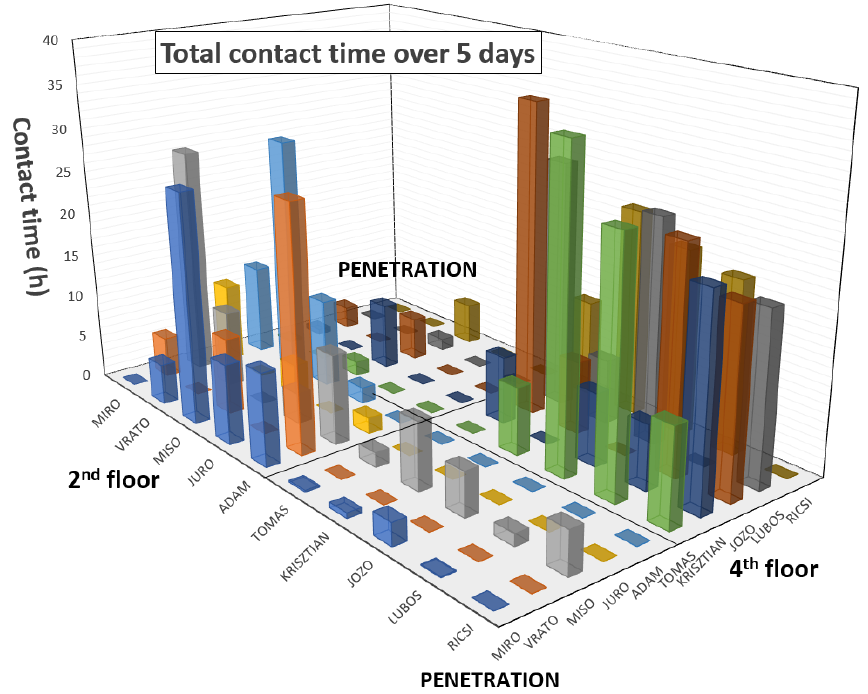
Figure 9. Functional testing—5-day contact time analysis: 2 separate working groups (2nd floor and 4th floor) and their cooperation (penetration).